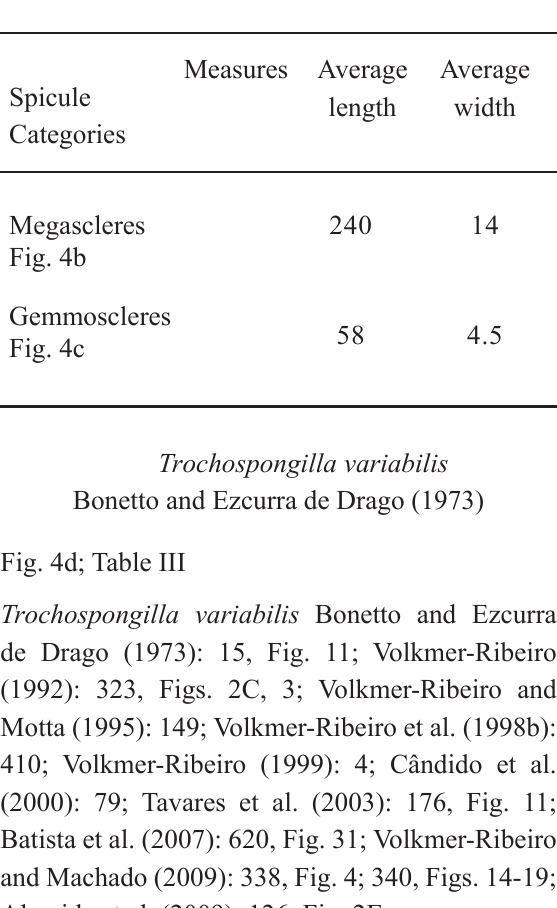
Category and measures (µm) of spicules of R. amazonensis detected in the three studied sections. All categories are frequent. Gemmoscleres are smaller than in the original description.